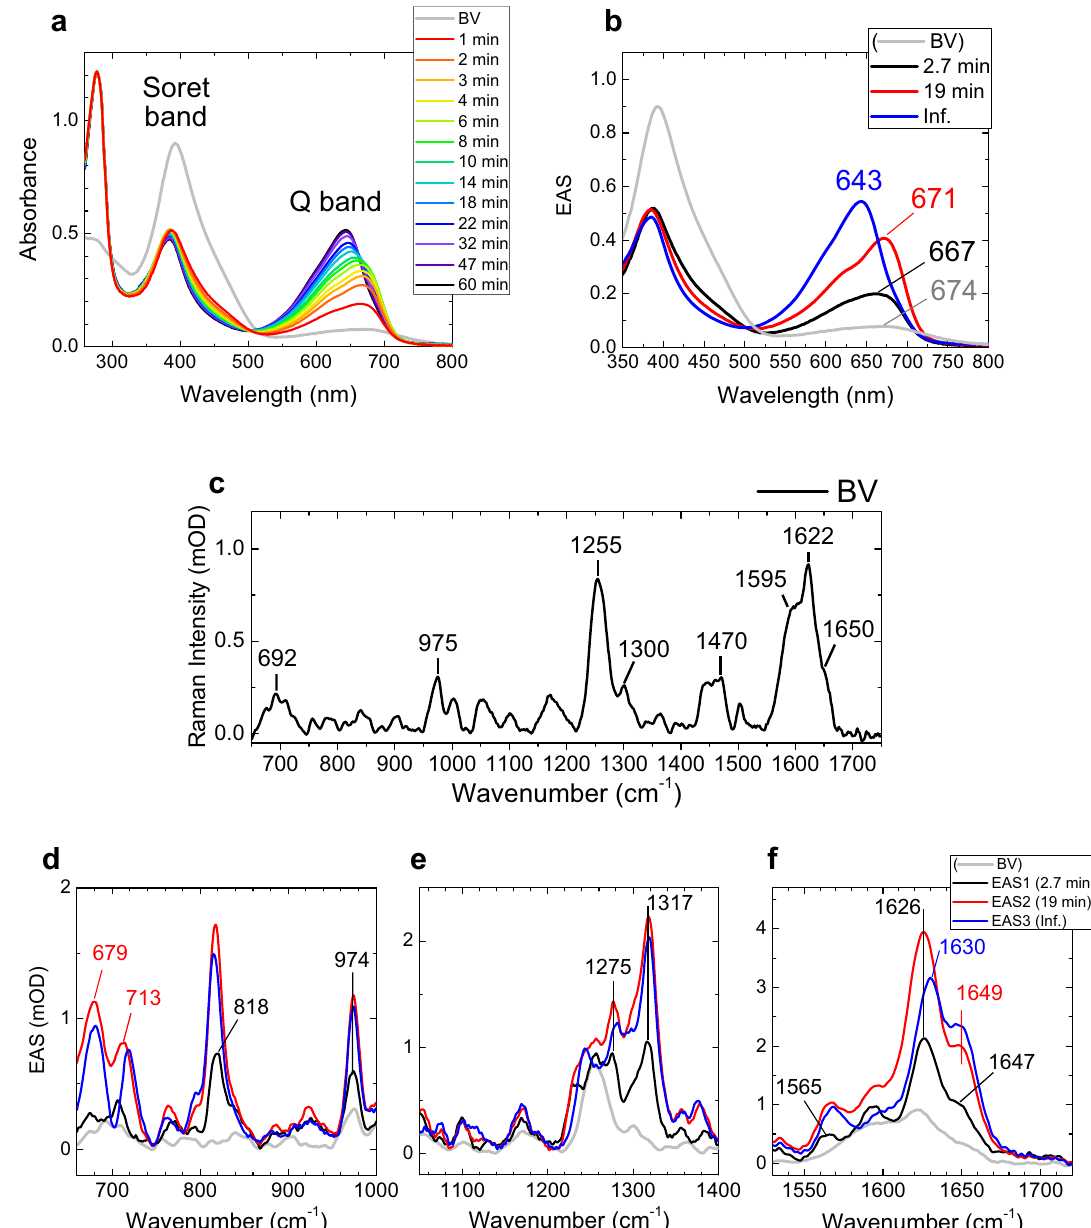
Fig. 2 Time-resolved absorption and Raman spectra of miRFP670/C20A at pH 8.0. a Selected time-resolved absorption spectra at the times indicated. b stimulated Raman spectrum of biliverdin (BV) prior to addition of apoprotein (gray line); Evolution-associated spectra (EAS) of globally fi tted time- resolved absorption spectra. The indicated time constants denote the lifetime by which each EAS evolves into the next one. c Stimulated Raman spectrum of BV in a buffer solution with an 800 nm Raman pump. d – f EAS of globally fi tted time-resolved stimulated Raman spectra with an 800 nm Raman pump. The gray lines denote the stimulated Raman spectrum BV in buffer solution reproduced from ( c